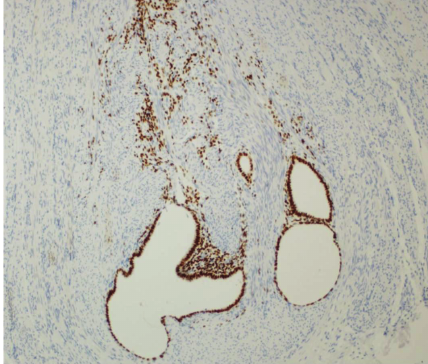
Figure 4: Both endometrial epithelial and stromal cells are highlighted by positive ER immunoreactivity (DAB, ×